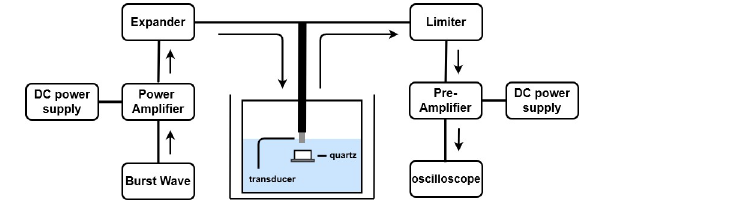
Fig 11. Ultrasonic pulse echo measurement process.